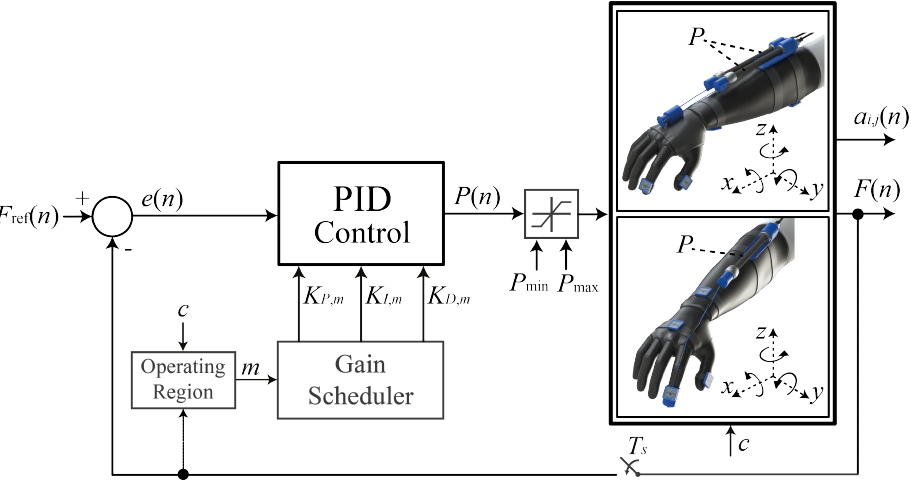
Figure 3. Block diagram of the incorporated control